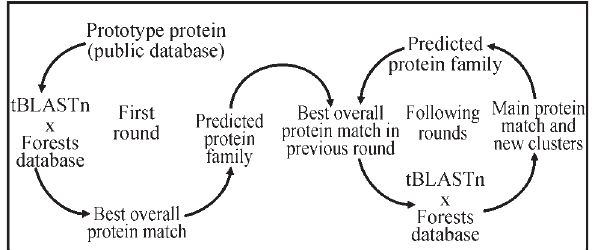
Figure 1 - Data mining and annotation strategy flowchart. Translated amino acid sequences of specific mRNAs were chosen from chaperones andstress-relatedproteinsasdescribedbyBorges etal .(2001).Theproto- type sequences were compared with the first level cluster consensus gen- erated by the Eucalyptus Genome Sequencing Project Consortium (FORESTs) using the basic local alignment search tool tBLASTn pro- gram (Altschul et al ., 1997). The tBLASTn program was used to compare amino acid sequences from public databases with the FORESTs database. The FORESTs cluster sequences with an E-value lower than 1e-5 were consideredtobelongtothechaperonecategory.Toimprovetheprediction accuracy, matches found in the first round of mining went through a sec- ond or even more rounds of mining, allowing precise identification of more matches and/or new Clusters not previously